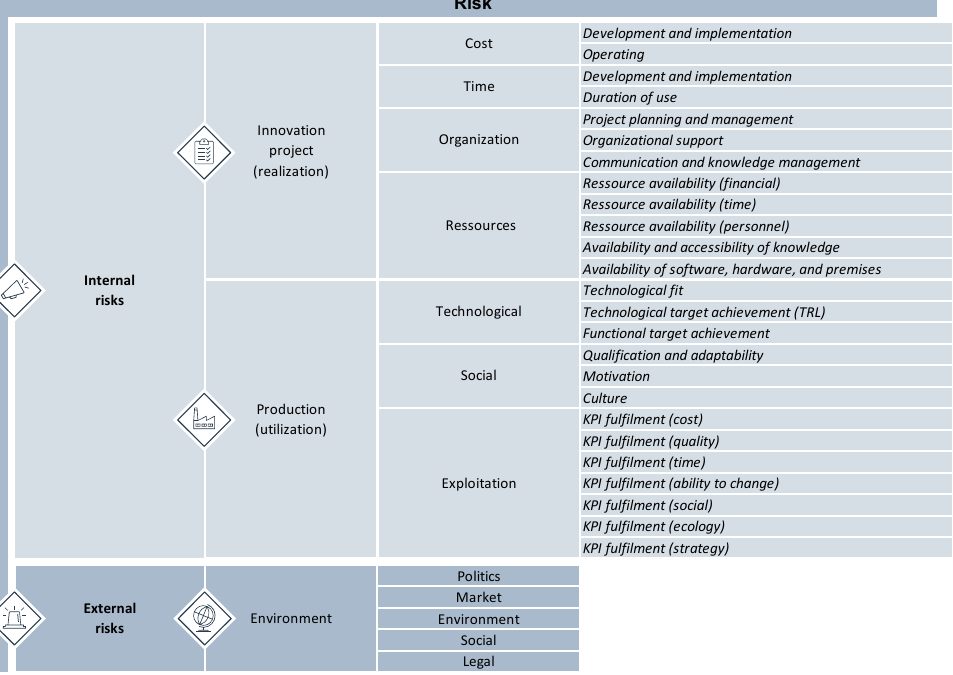
Figure 6. Relevant criteria to assess the risks of innovation projects in manufacturing.